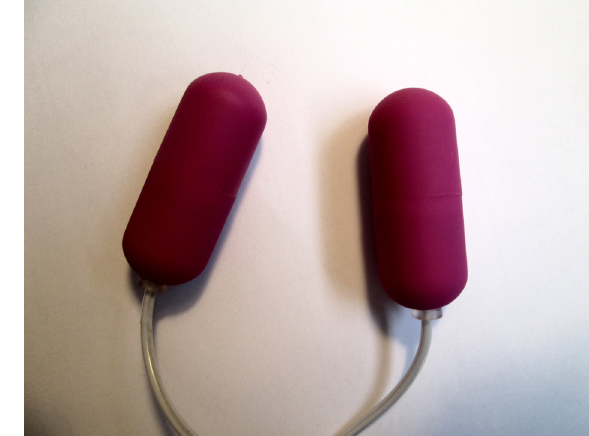
Figure 9: Bullet vibrators.